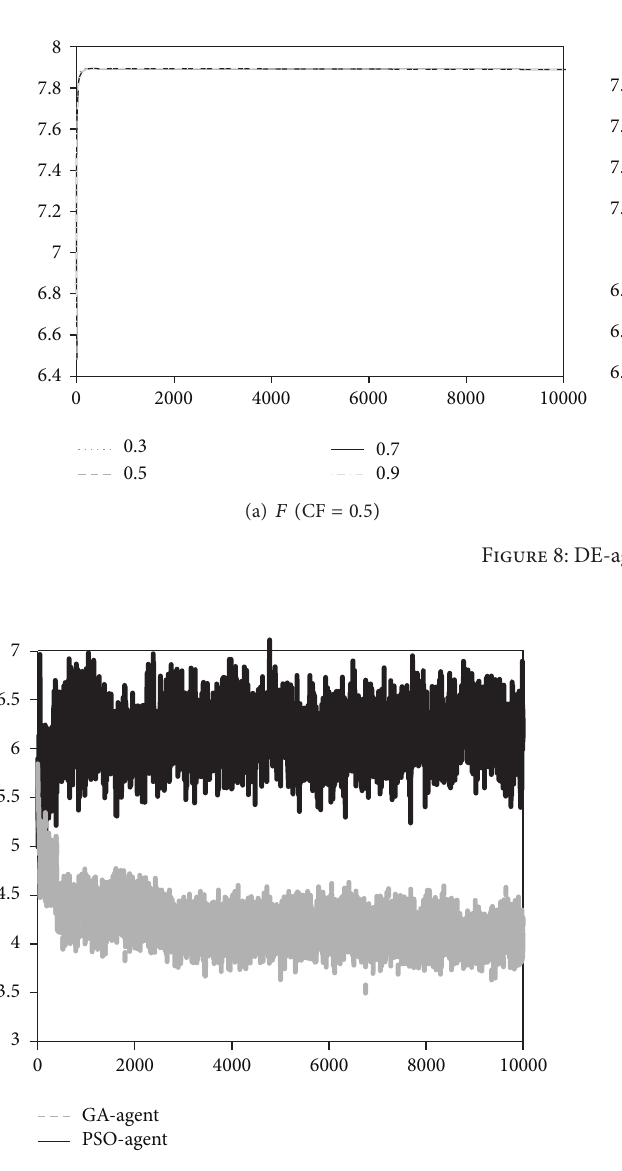
Figure 9: GA-agent versus PSO-agent.